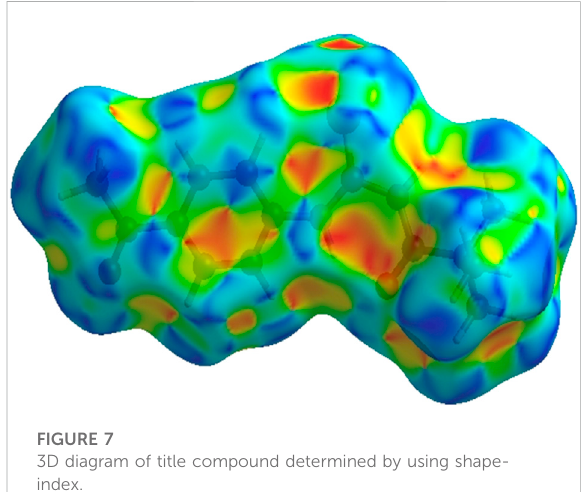
FIGURE 7 3D diagram of title compound determined by using shape-